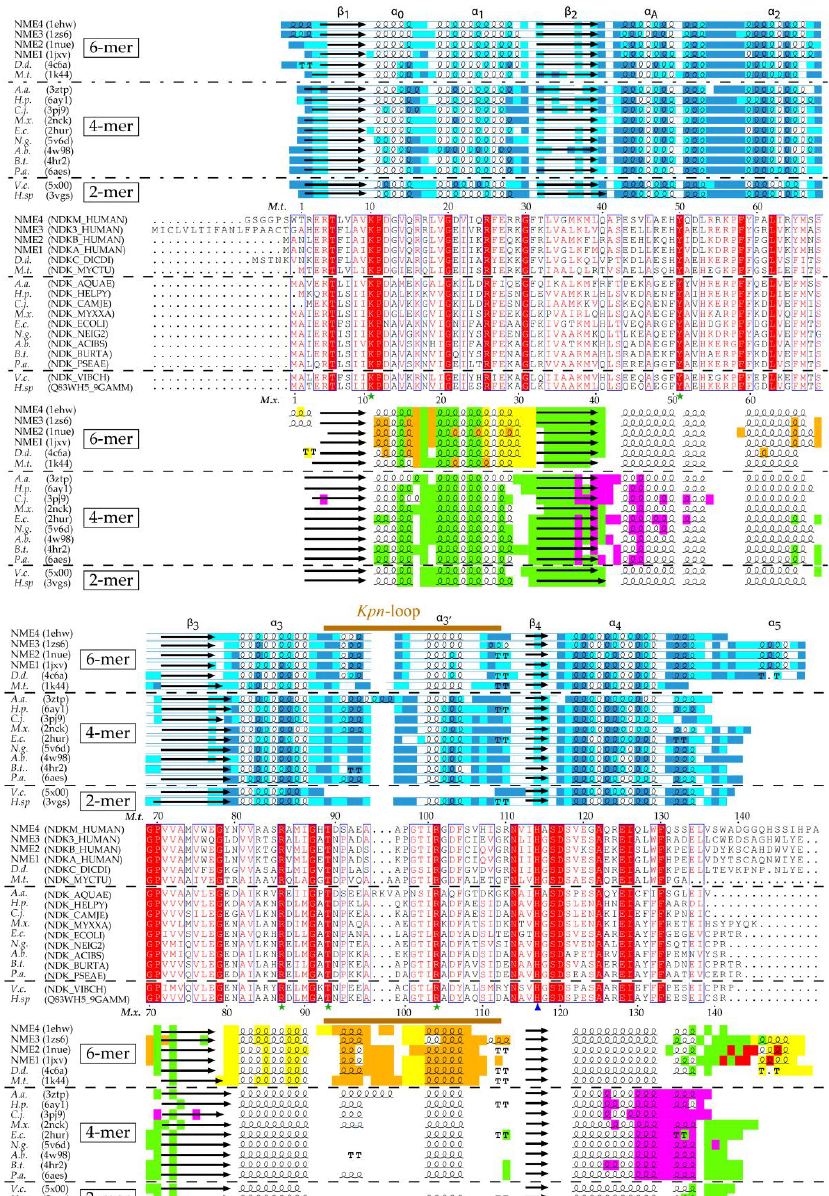
Figure 1. Secondary structure, residue accessibility, sequence and interface alignments of hexamer, tetramer and dimer NDPKs (nucleoside diphosphate kinases) with known 3D structure. (i) The relative accessibility and the secondary structure of each residue were calculated using DSSP (Database of Secondary Structure of Proteins) [31]. The accessibility is rendered as colored boxes (marine, cyan and white for accessible, intermediate and buried, respectively). α-helices, β-strands and strict β-turns are displayed as squiggles, arrows and TT letters, respectively. The conventional names of the NDPK secondary structure elements and the Kpn -loop are indicated above. (ii) On sequence alignment, strictly conserved residues are in white on a red background while similar residues are in red on a white background with blue frames (with numbered residues of M.t. and M.x. marked above and below the alignment, respectively). The active site residues and the catalytic histidine are indicated by a green star, and a blue arrow, respectively. (iii) The various interfaces are highlighted in different colors: green for the common-dimer interface, maroon and yellow for the trimer interfaces, red for the C Term trimer interface, magenta for tetramer interface. The interfaces were identified using PISA (Proteins, Interfaces, Structures and Assemblies) [32]. The figure was drawn with ESPript3 [33]. ( NME 1 to 4 , Non Metastatic human isoforms 1 to 4, D.d. , D. discoideum ; M.t. , M. tuberculosis ; A.a. , A. aeolicus; H.p. , H. pylori; C.j. , C. jejuni ; M.x. , M. xanthus ; E.c., E. coli ; N.g. , N. gonorrhoeae; A.b. , A. baumannii; B.t. , B. thailandensis ; P.a., P. aeruginosa ; V.c. , V. cholerae ; H. sp, Halomonas sp. 593 ). The PDB and Uniprot Ids are in parentheses.